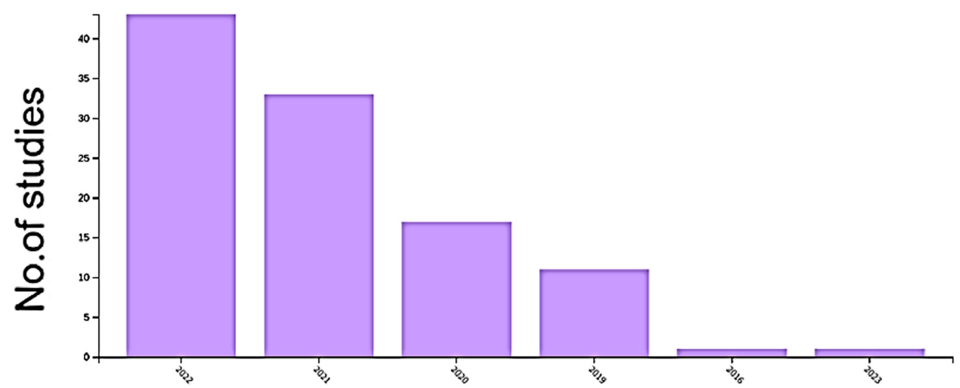
Figure 6. The Web-of-Science annual distribution of Vision Transformer techniques. Since 2020, the number of studies on Vision Transformer applications in WOS has expanded considerably.